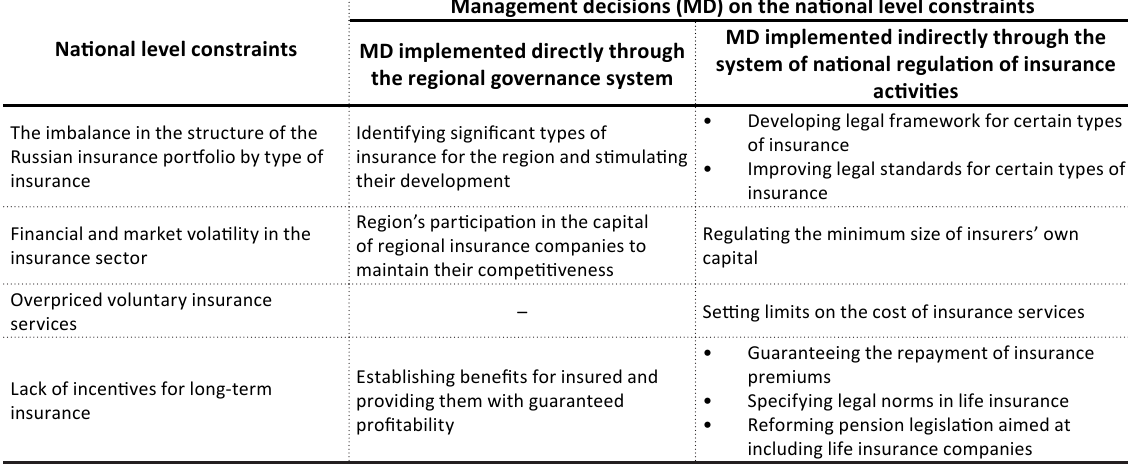
Table 4. Example of managing the national constraints of the insurance market affecting the RIM